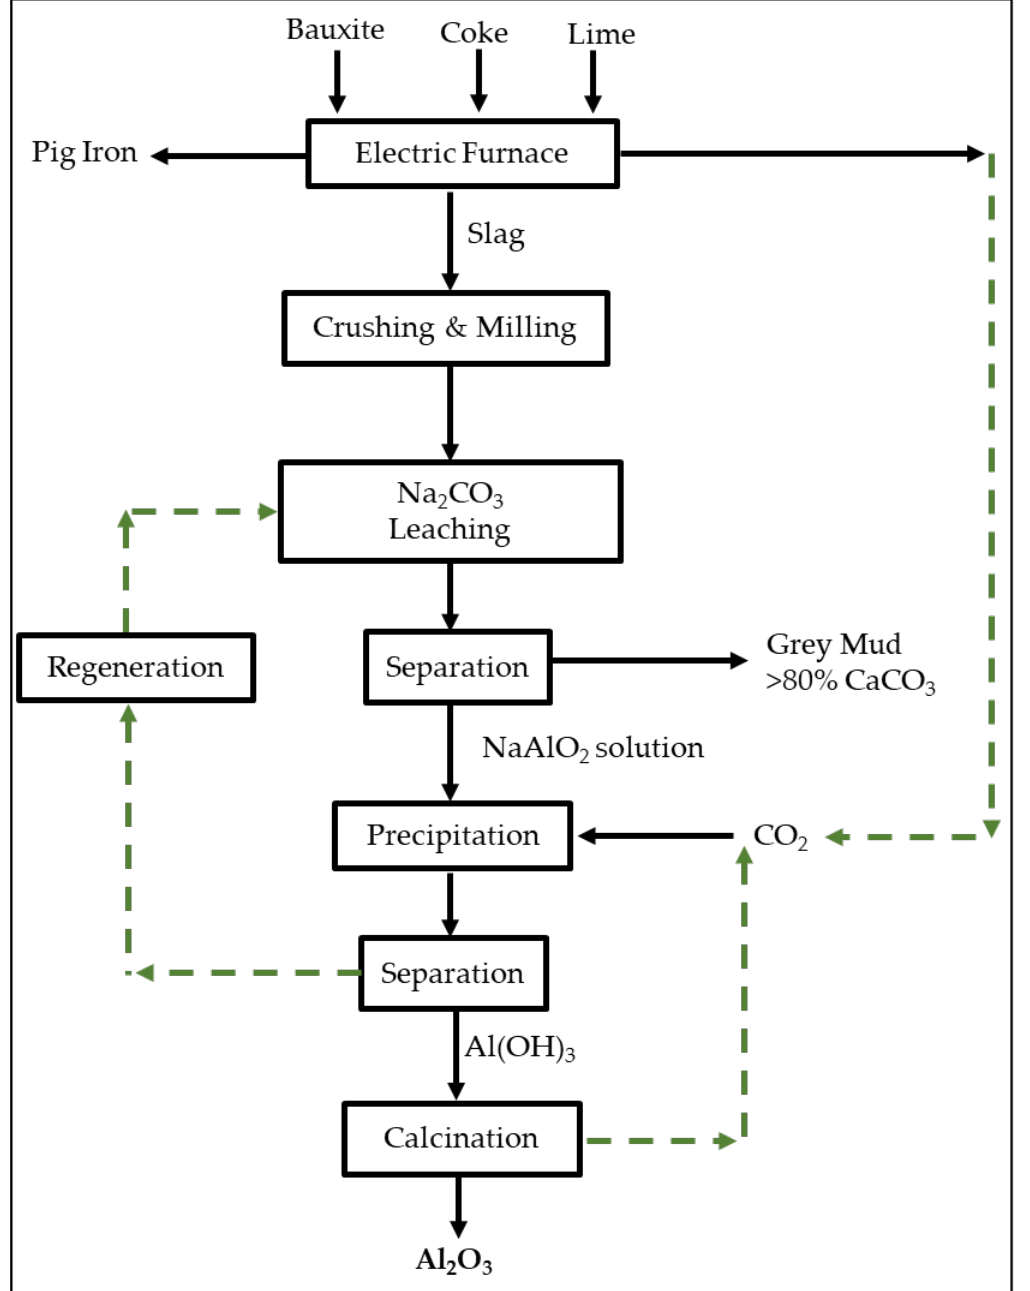
Figure 1 . Mass flow diagram of the Pedersen process . Figure 1. Mass flow diagram of the Pedersen